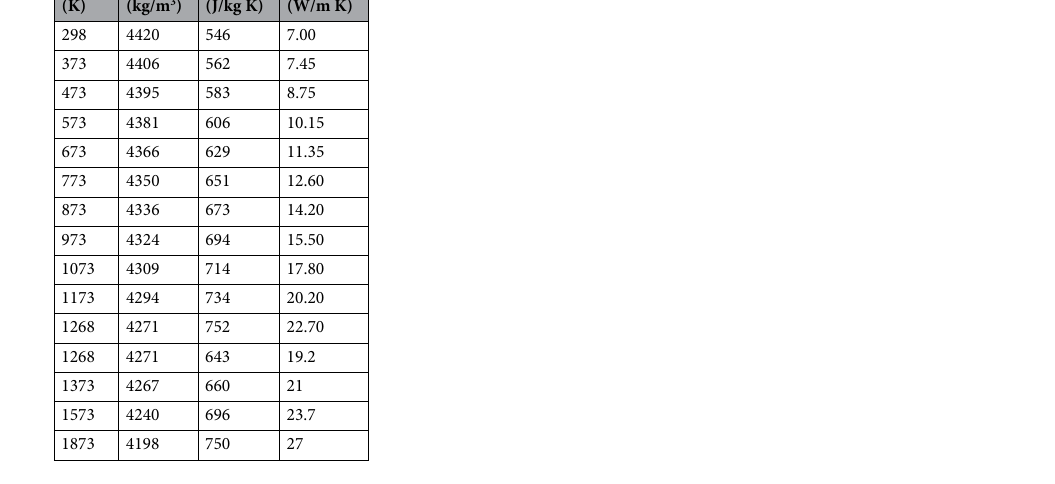
Table 1. Thermo-physical properties of